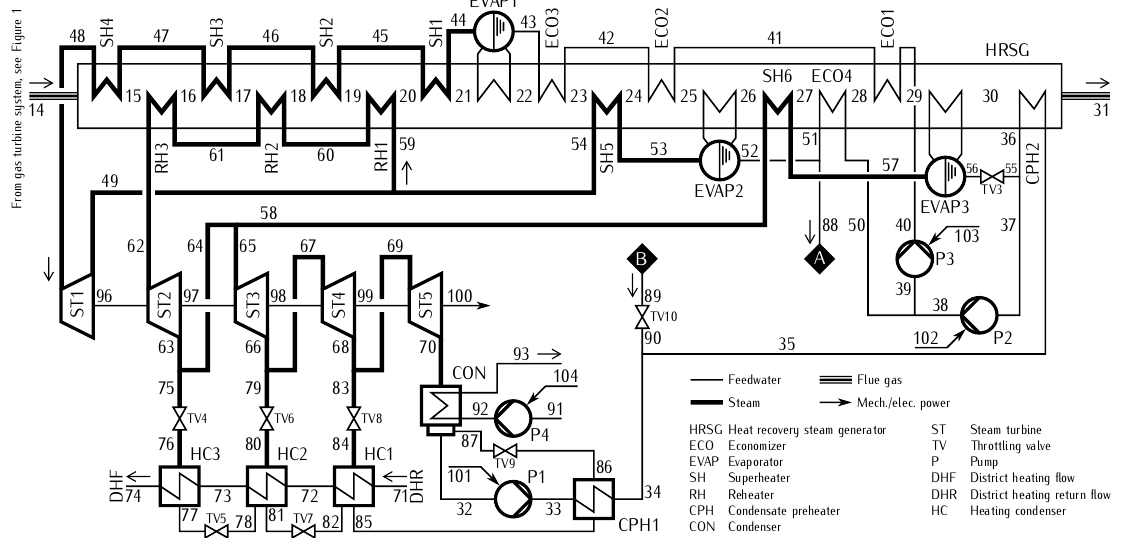
Figure 5. Flow diagram of the simulated combined cycle gas turbine process, for gas turbine system see Figure1.